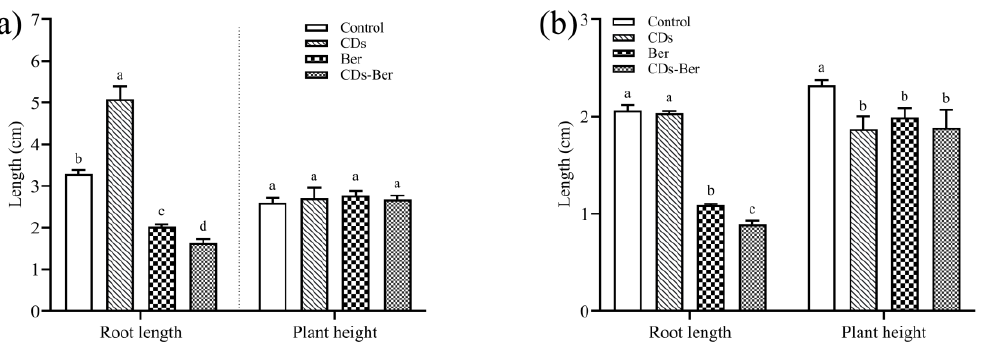
Figure 5. Effects of CDs, berberine, and CDs-Ber treatments on root length and plant height of Echinochloa crus-galli ( a ) and Amaranthus retroflexus ( b ), control is deionized water. Note: data are presented as mean ± SD ( n = 4). Comparison within the group, different letters indicate significant differences, the same letter indicates no significant difference ( p < 0.05, LSD test).